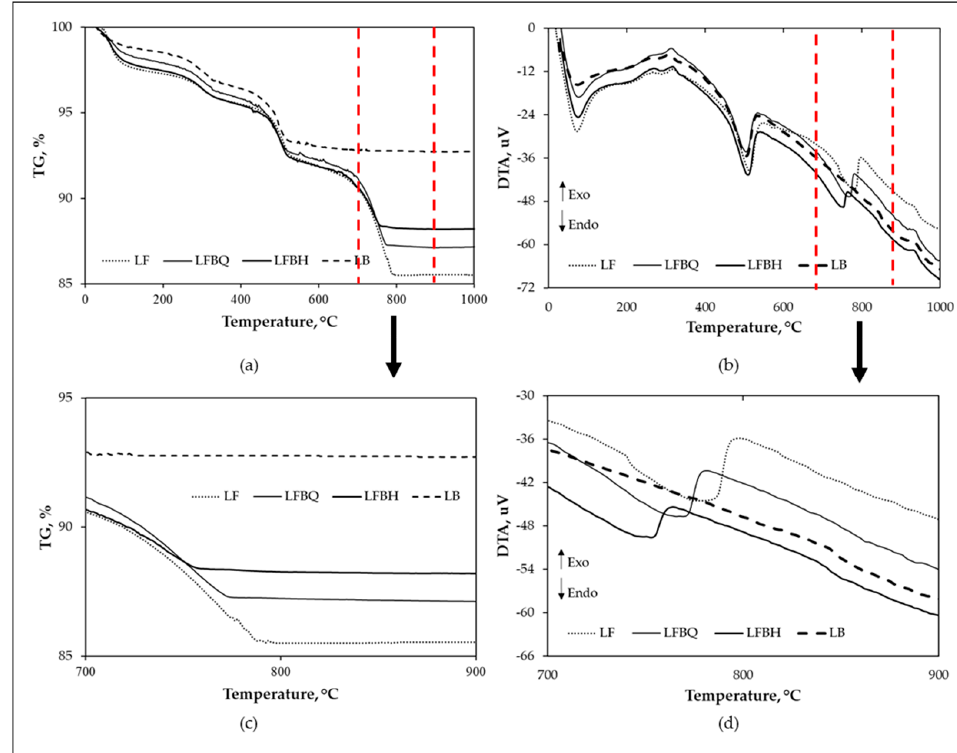
Figure 5. Analysis of different formulations: ( a ) TG; ( b ) DTA; ( c ) portion of TG curve ( a ) showing the different behaviors of the formulations at 700–900 °C; and ( d ) portion of DTA curve ( b ) showing the different behaviors of the formulations at 700–900 °C .